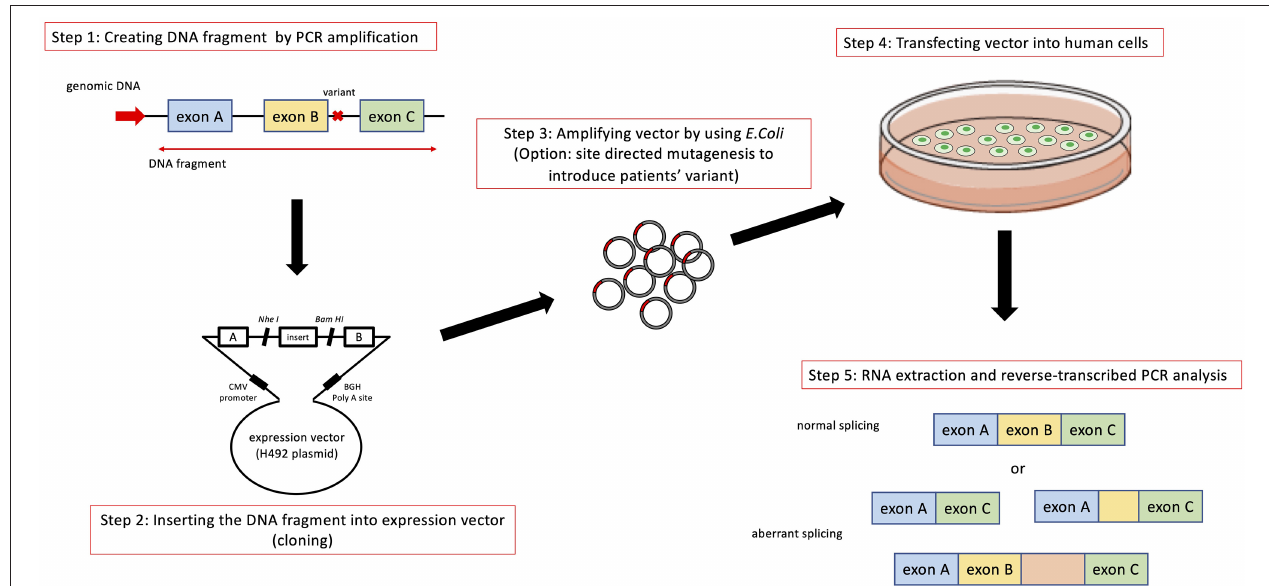
FIGURE 3 | Schematic diagram of minigene analysis to test possible splicing variants. Step 1: Cleaving DNA fragment including the position of mutation by PCR from wild type and patient’s gDNA. In addition to the exon close to the mutation being analyzed, we routinely include prier and following exons in DNA fragment. Step 2: Hybrid minigene constructs are created by inserting a test sequence fragment consisting of target exons and its flanking introns into the multicloning site within an intervening intron between two exons (exon A and B) of the minigene construct. Step 3: The hybrid minigene (cloning reaction) is amplified using E. coli . If patient’s gDNA is not available, we introduce test mutation by using mutagenesis PCR. Step 4 and 5: These hybrid minigenes (both wild type and mutant) are transfected into human derived cells and culture them to express minigene derived mRNA. Step 5: Total RNA is reverse-transcribed into cDNA and the PCR is performed using specific. PCR products are analyzed by means of electrophoresis and direct